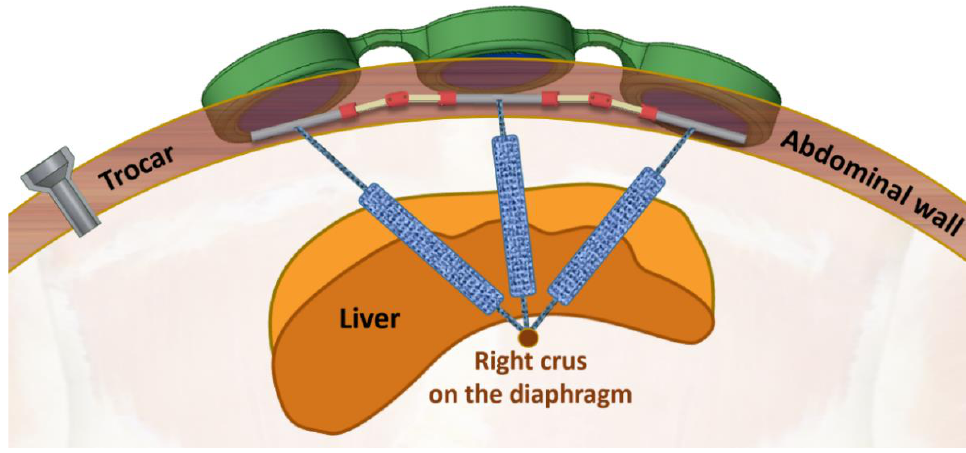
Figure 23. Illustration of the complete anchoring system CAD model assembly in the used scenario.